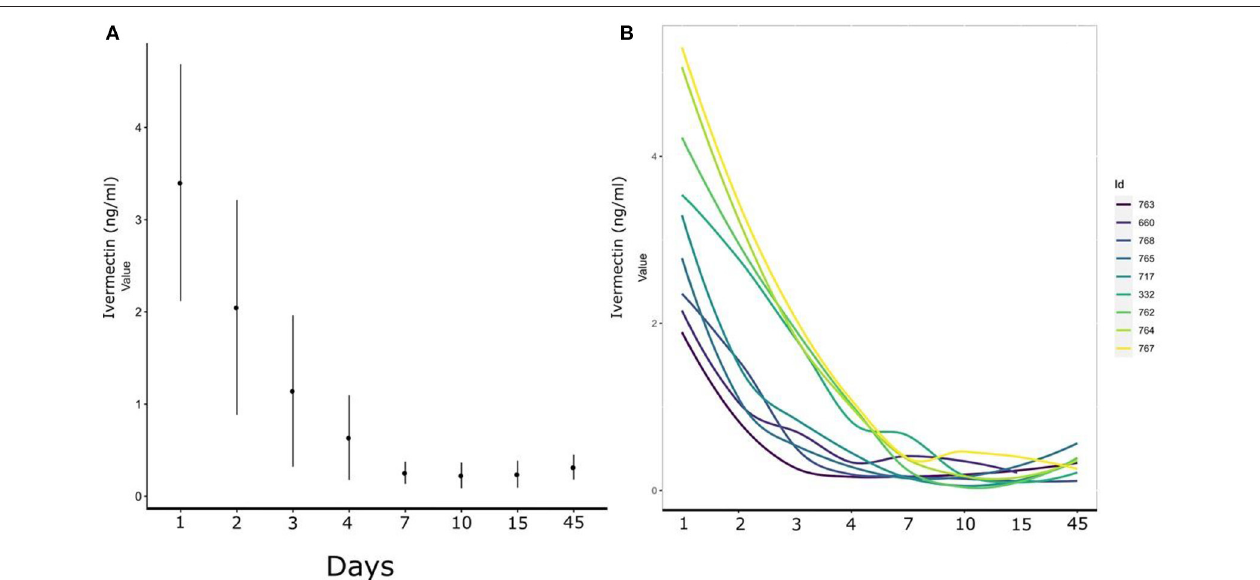
FIGURE 1 | (A) Time trend of the mean plasma ivermectin concentration (ng/ml) in the nine Iberian ibexes orally administered with ivermectin from 1 (T1) to 45 (T8) days post-administration; (B) Differences among individual ibexes in the decrease of plasma ivermectin concentration throughout the study period.